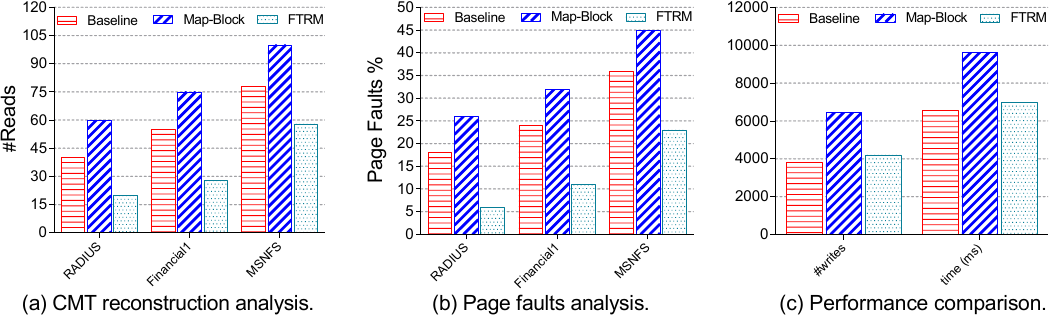
Figure 6. Reliability and efficiency comparison between Baseline, Map-Block, and our proposed FTRM approach. ( a ) Reconstruction analysis using mapping reads count; ( b ) percentage number of page faults after system reboot; and ( c ) performance comparison through writes and time